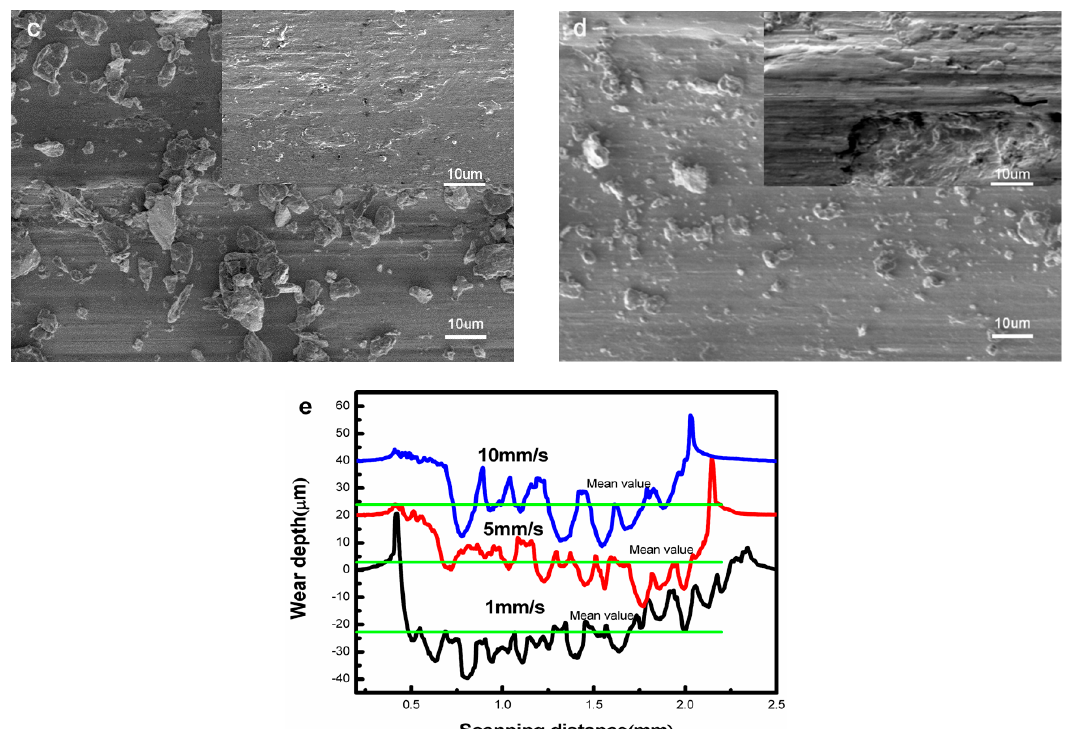
Figure 6. The SEM images of as-worn surfaces of the brass plates at a load of 3 kg after a sliding distance of 60 m. The insets show the SEM images of the cleaned surfaces of corresponding samples. ( a – c ) As-worn brass surfaces against Ni-based pins at the sliding speeds of 1 mm/s, 5 mm/s, 10 mm/s, respectively; ( d ) the as-worn surface against GCr15 steel at a speed of 1 mm/s; ( e ) the cross-section wear tracks of the cleaned worn surfaces of the brass plates at different sliding speeds.